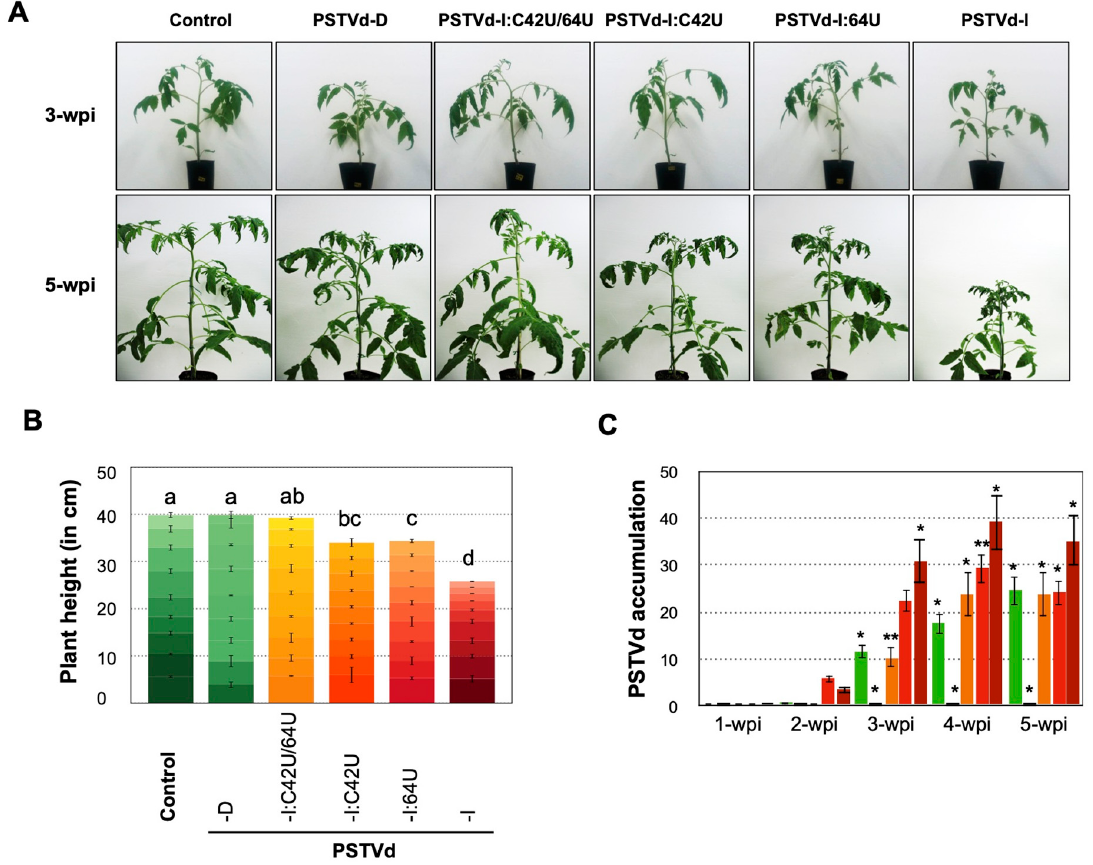
Figure 2. Mutation at nucleotide positions 42 and 64 of PSTVd-I attenuated symptom in tomato plants. Tomato plants inoculated with low molecular weight (LMW)-RNA of PSTVd-D wt , PSTVd-I wt , and mutants of PSTVd-I (PSTVd-I:C42U, PSTVd-I:64U and, PSTVd-I:C42U/64U) to examine the role of specific nucleotides in symptom attenuation. ( A ) Plants inoculated with LMW-RNA of PSTVd-I wt exhibited leaf malformation at 3-wpi and severe dwarfing symptoms at 5-wpi whereas LMW-RNA of PSTVd-D inoculated plants resembled that of mock-inoculated control even at 5 wpi. Although plants inoculated with LMW-RNA of PSTVd-I:C42U and PSTVd-I:64U exhibited mild leaf malformation at 5-wpi, none of the plants inoculated with LMW-RNA of PSTVd-I:C42U/64U show any visible symptoms. ( B ) A schematic diagram of the comparison of the 9 internodes and accumulated height of the mock-inoculated control plants, and those infected with PSTVd-D wt , PSTVd-I:C42U/64U, PSTVd-I:64U, PSTVd-I:C42U, and PSTVd-I wt at 5-wpi. Different letters (a to d) on the top of the bars indicate statistical significance with a p -value of 0.05 ( t -test). Mean values are based on three replicates. ( C ) Comparative analysis of the accumulation of viroid RNAs in infected tomato plants in time course (1- to 5-wpi) by Northern blot hybridization. Accumulation of viroid RNA was calculated by measuring the band intensity in ChemiDoc-XRS by Quantity One software and normalized by the mean value of PSTVd-I wt at 2-wpi as 1.0. A t -test was performed with a p -value of 0.05. * and ** on the top of the bars represent a significant difference of <0.05 and <0.01, respectively. Mean values are based on three biological and three technical replicates. In the figure, green bars indicate PSTVd-D wt inoculated plants, yellow-colored bars indicate PSTVd-I:C42U/64U inoculated plants, orange-colored bars indicate PSTVd-I:C42U inoculated plants, red bars indicate PSTVd-I:64U inoculated plants, dark red colored bars indicate PSTVd-I wt inoculated plants, respectively.